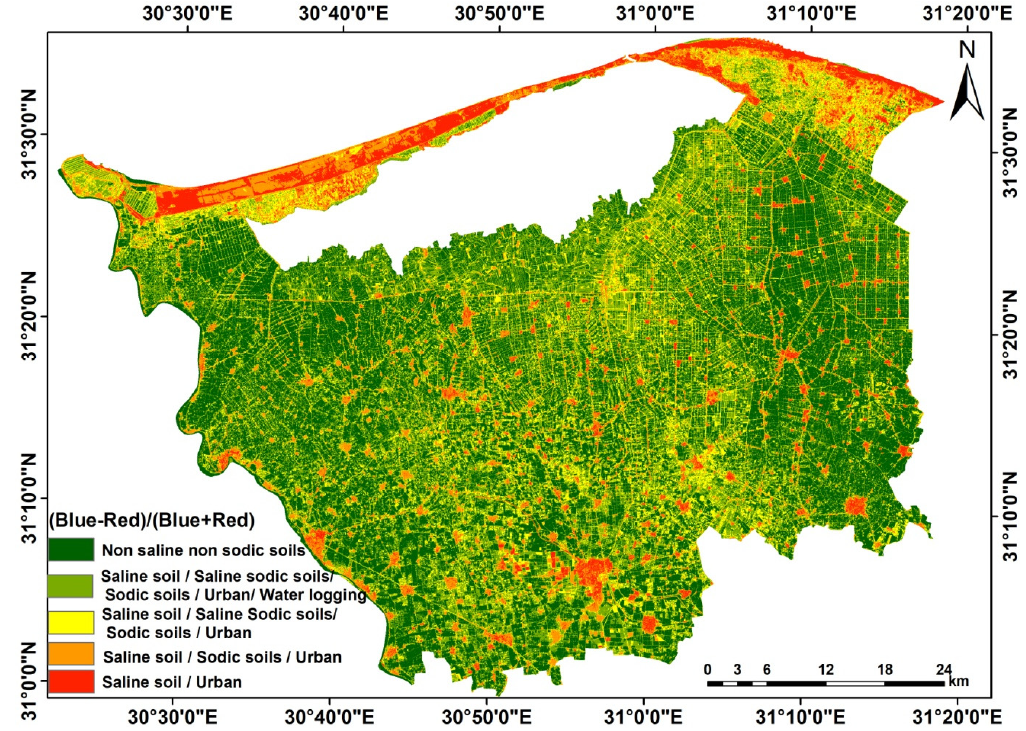
Figure 6 . 3rd part of the equation (Blue − Red/Blue + Red) applied on 2021. Figure 6. 3rd part of the equation (Blue − Red/Blue + Red) applied on